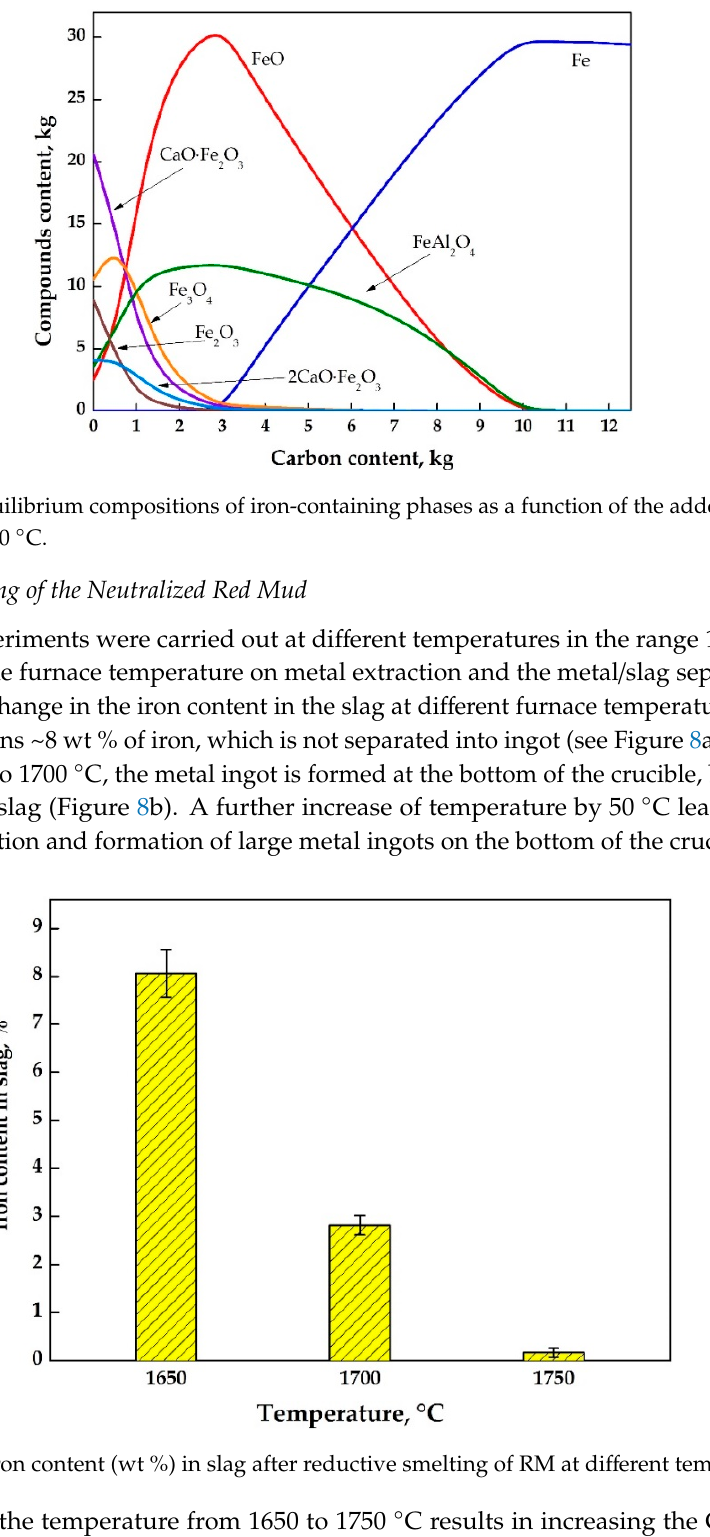
◦ C results in increasing the CaO and Al 2 O 3 ◦ C, which ◦ C, TiO 2 reduces